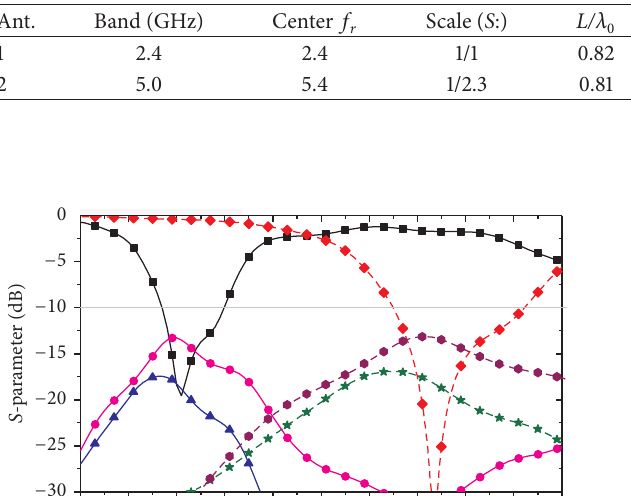
Table 1: Dimensions of the proposed scalable antenna system (unit: mm).